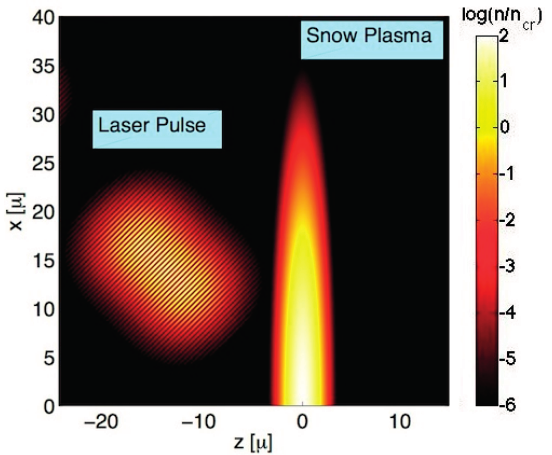
Figure 3. Spatial distribution of the electron plasma of the whisker before the start of the interaction with the main pulse. The upper half of the whisker is displayed. The density of the plasma is logarithmic scaled by the critical density. One can see a central dense core, surrounded by gradually lower density region. The laser electric field is schematically shown and not to scale (Adapted with permission from [16], published by American Physical Society,